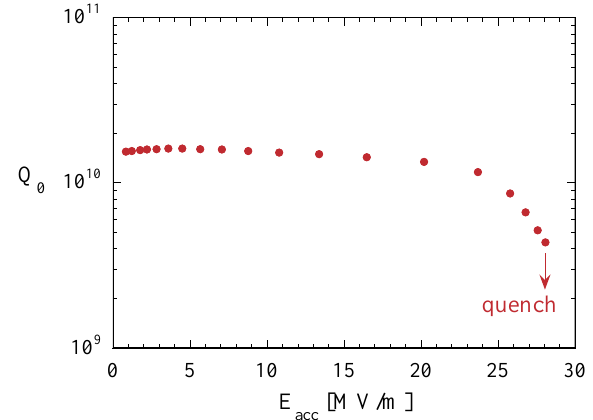
FIG. 30. (Color) Excitation curve of a TESLA 9-cell cavity showing a drop of quality factor without any field emission. CERN, DESY, KEK, and Saclay started a joint